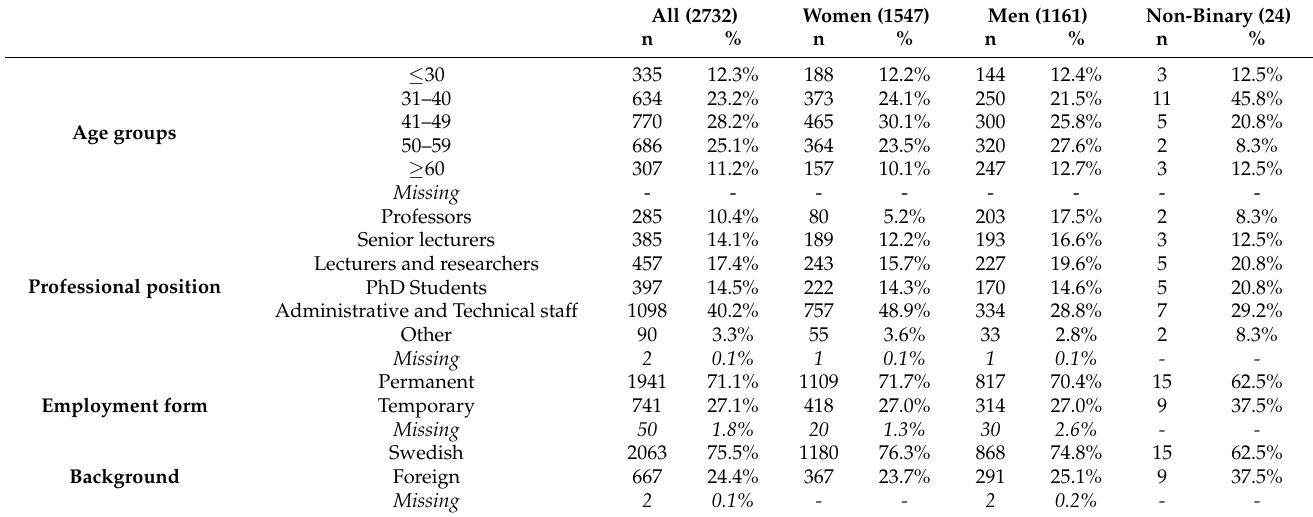
Table 1. Sociodemographic characteristics of the sample, by